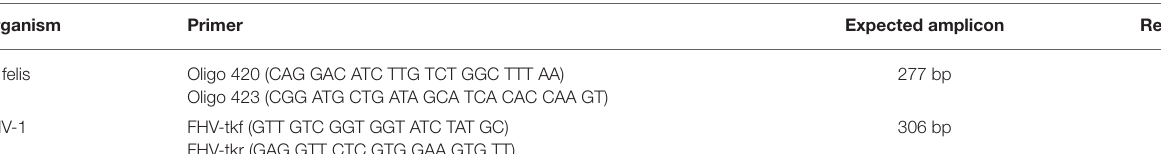
TABLE 1 | Primer sequences for Chlamydophila felis and FHV-1. Organism